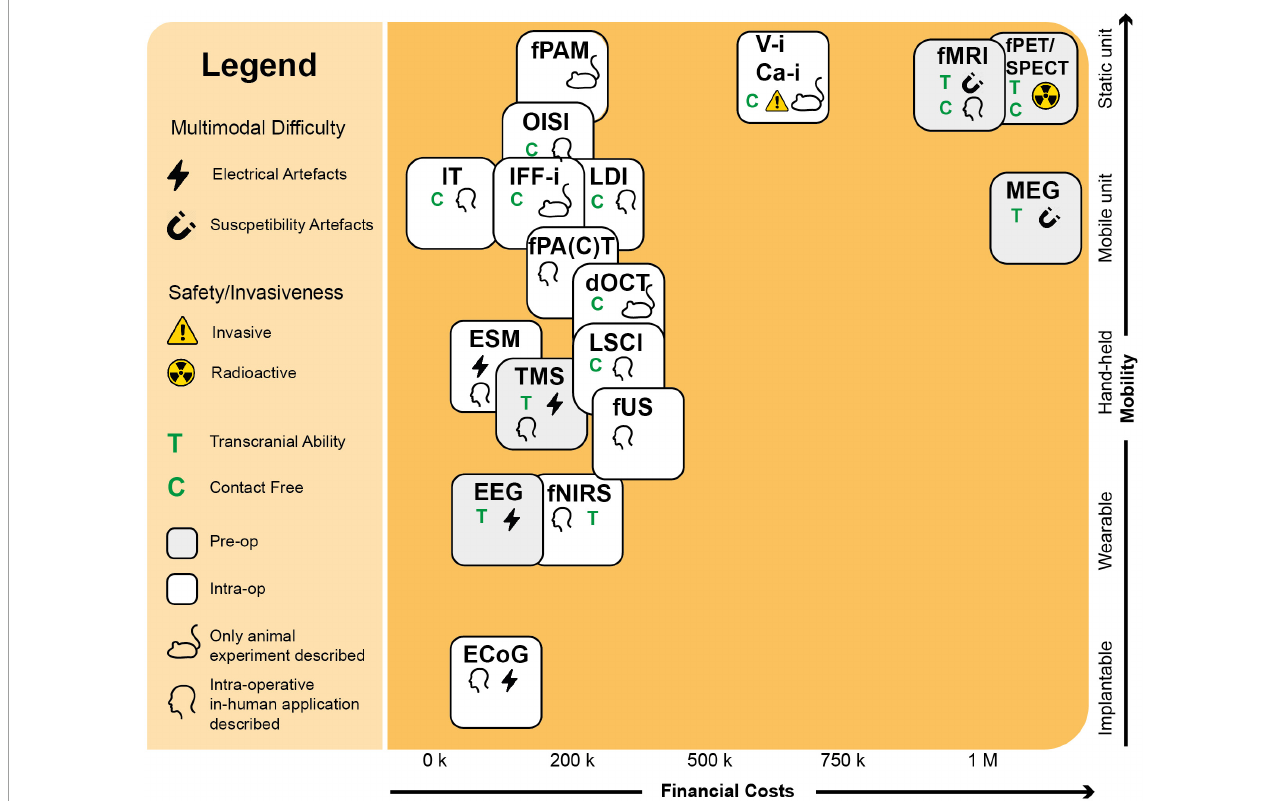
FIGURE4 Requirements for the intra-operative context. Here we see an overview of the functional neuro-imaging landscape, drawn up using parameters with a clinical and intra-operative relevance. In the upper right corner, we see a group of three pre-operative techniques (MEG, fMRI, fPET/SPECT) with high costs and limited mobility, partially explaining their limited intra-operative applicability. Also the contact-level needed for the technique to function can dictate the technique’s intra-operative applicability. Optical techniques such as OISI and IT, make use of stand-alone cameras or integrated versions into conventional surgical microscopes, which does not require any substantial interruption of the surgical flow. Techniques such as fUS or PAI come in mobile, hand-held acquisition units, which do not take up much space in the operating room. A technique’s multimodal potential is also important and can be complicated by electrical or susceptibility artifacts. Finally, the level of invasiveness can severely determine its clinical success. As Ca-i and V-i require introduction of alien fluorescent markers, their clinical applications is more complicated than techniques such as OISI and IFF-i which rely on intrinsic fluorescence. ECoG, electrocorticography; EEG, electroencephalography; MEG, magnetoencephalography; ESM, electrocortical stimulation; Ca-i, calcium-imaging; V-i, voltage-imaging; TMS, transcranial magnetic stimulation; NVC, neurovascular coupling; PAI, photo-acoustic imaging; fNIRS, functional near-infrared spectroscopy; dOCT, Doppler optical coherence tomography; fUS, functional ultrasound; LDI, laser Doppler imaging; LSCI, laser speckle contrast imaging; RBC, red blood cells; NMC, neurometabolic coupling; IFF-I, intrinsic functional fluorescence-imaging; IT, infrared thermography; OISI, optical intrinsic signal imaging; fMRI, functional magnetic resonance imaging; fPET, functional position emission tomography; SPECT, single-photon emission computed tomography; Pre-op, pre-operatively available only; Intra-op, intra-operatively